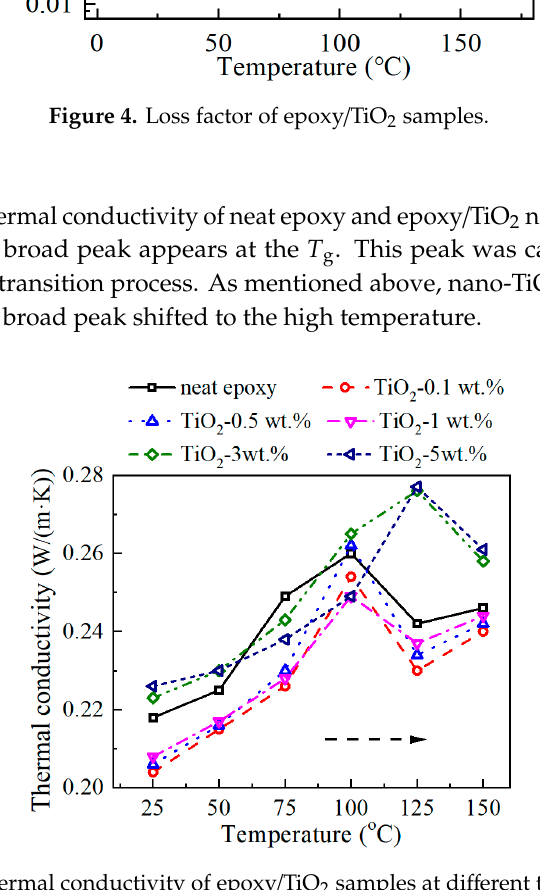
Figure 5. Thermal conductivity of epoxy/TiO 2 samples at different temperature.